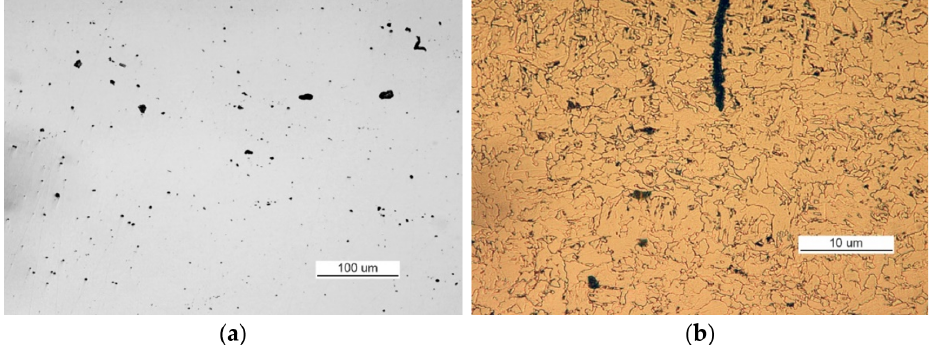
Figure 21. Optical microscopy views (handy-size bulk carrier 30206 DWT): ( a ) nonmetallic inclusions in the structure of element III (non-etched metallographic specimen) and ( b ) structure of the steel near the front of crack